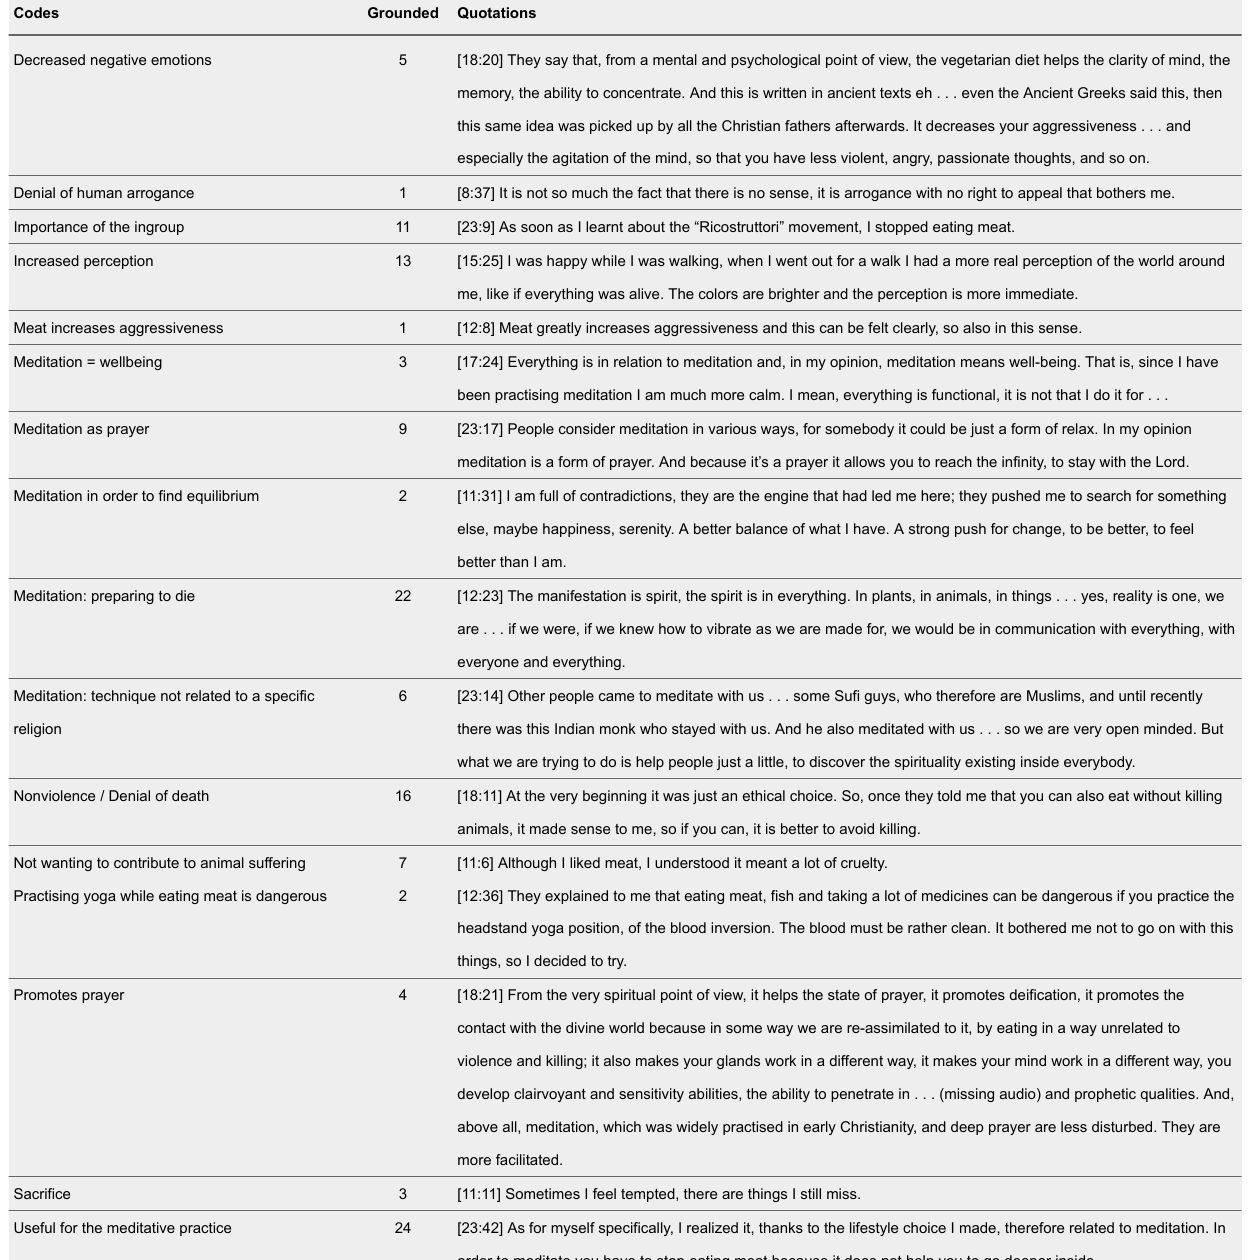
Spiritual Vegetarianism